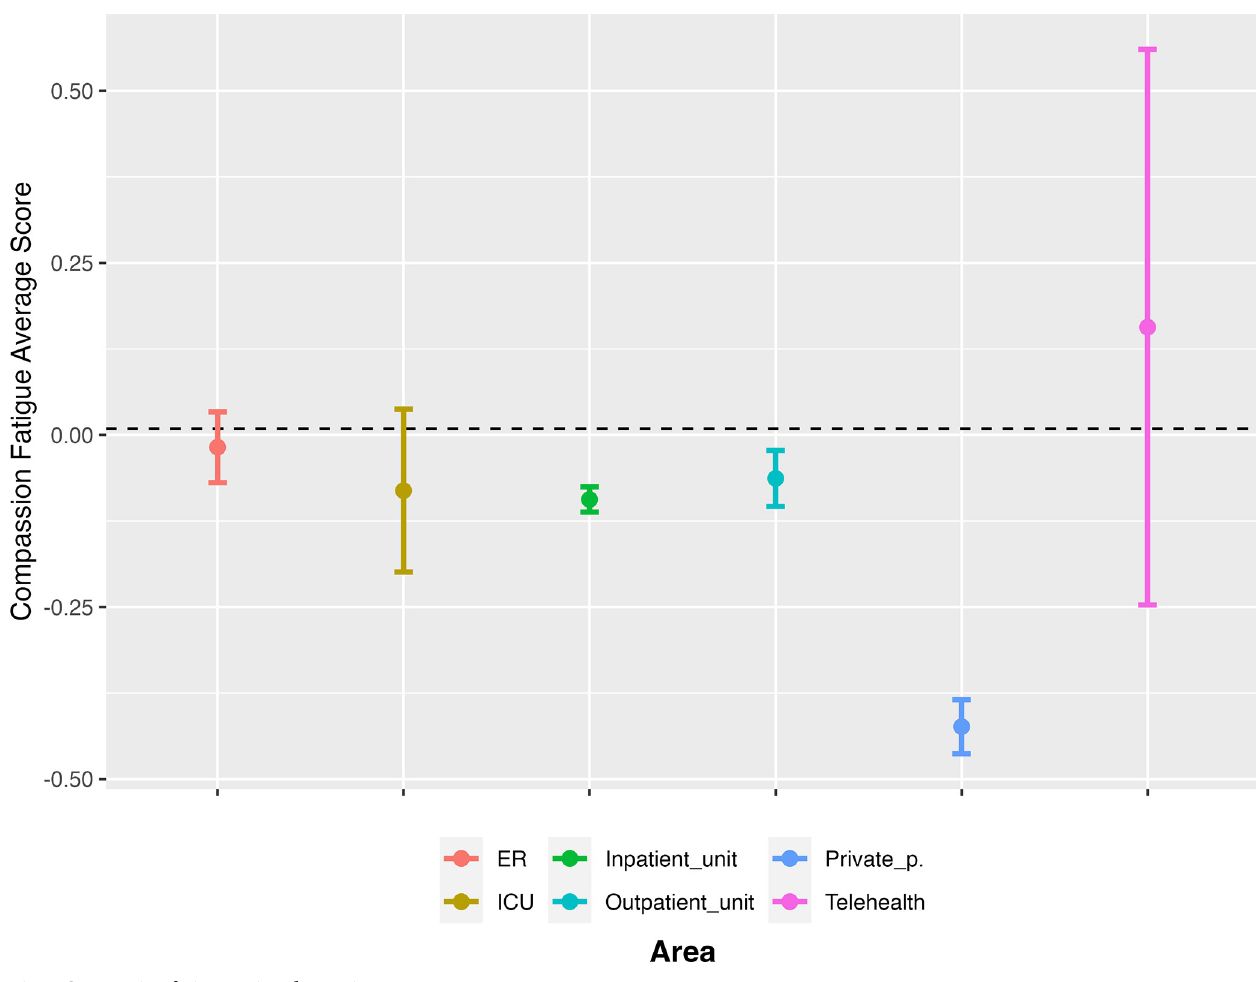
Fig 3. Compassion fatigue ratings by service